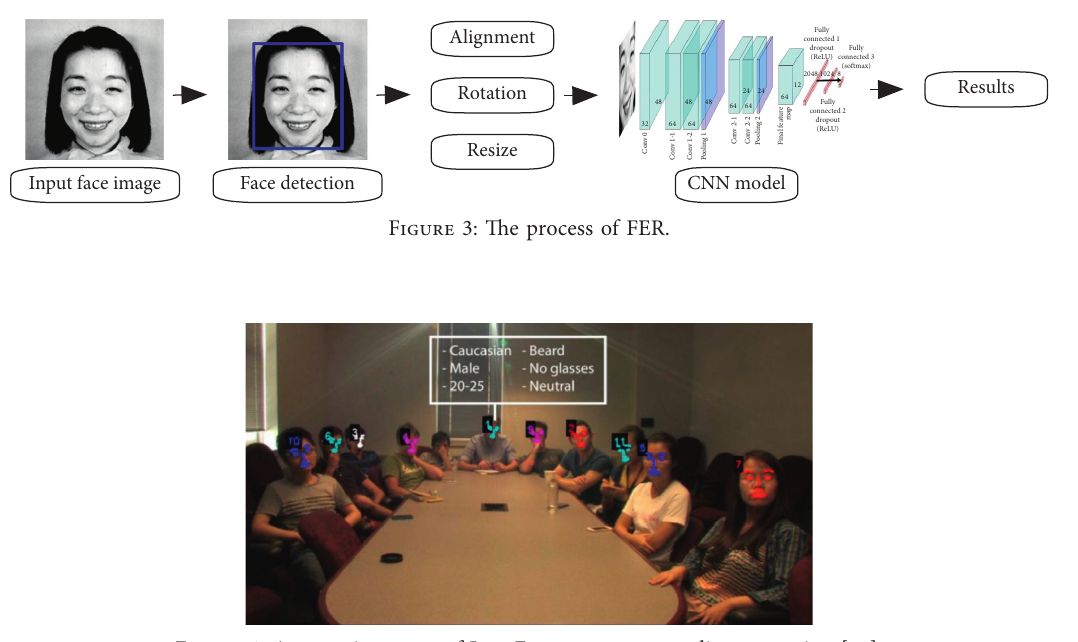
Figure 4: Automatic output of IntraFace to measure audience reaction [55].